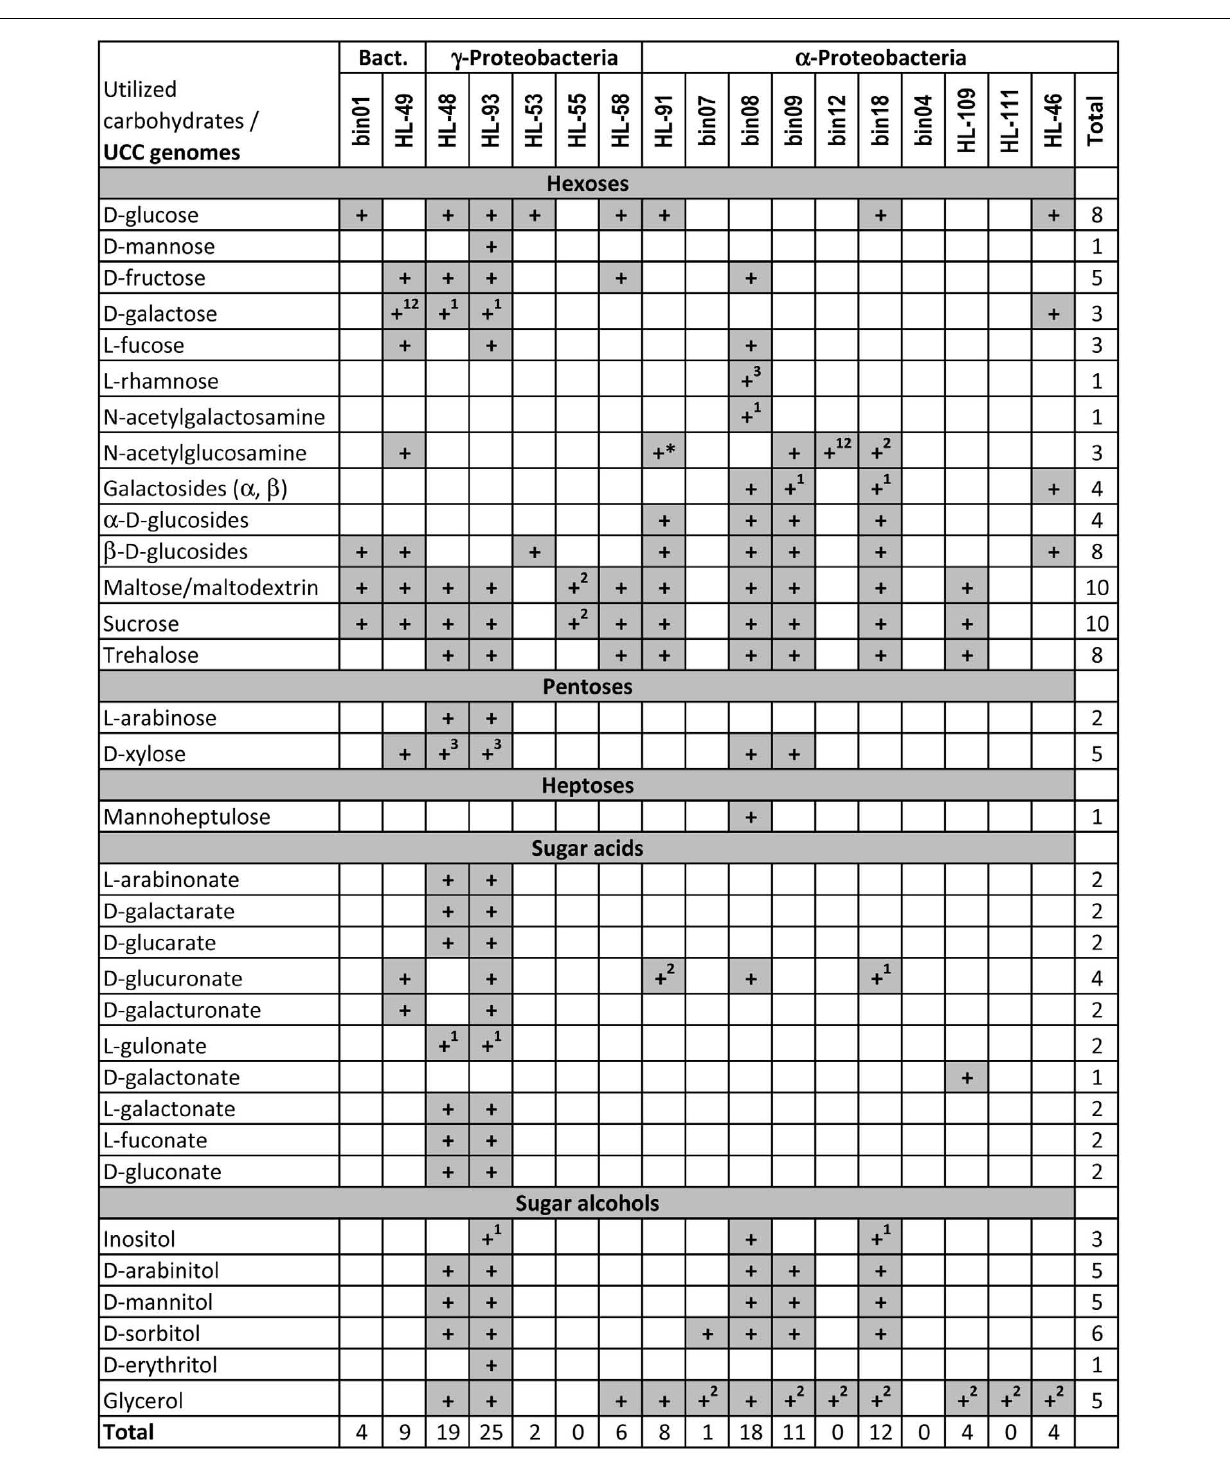
Frontiers in Microbiology |